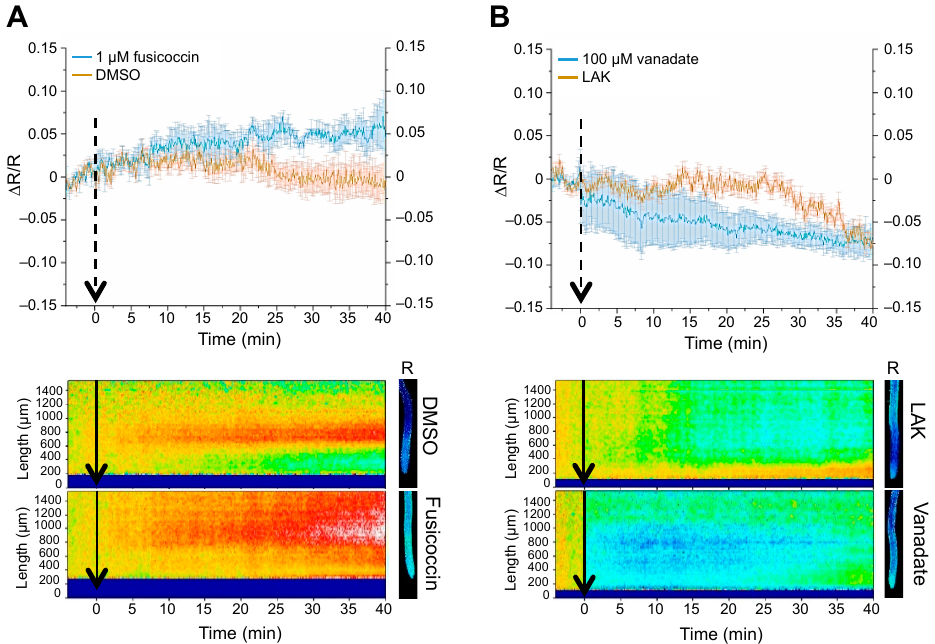
Figure 2. Response of pHGFP-LTI6b to altered activity of the PM H + -pump. pHGFP-LTI6b response to activation of the plasma membrane H + -ATPase by fusicoccin ( A ) and inhibition of the plasma membrane H + -ATPase by vanadate ( B ). Data in plots are the quantifications of Δ R/R in the MEZ zone. The plots represent the mean of 2 independent experiments ± SEM. Arrows indicate the time the treatment started. Heat-maps below show representative experiments. Pictures on the right show fluorescence emission ratio (R) images of representative roots used at the 35 min time point. Heat-maps and root pictures are representative of at least 2 independent experiments for each treatment.